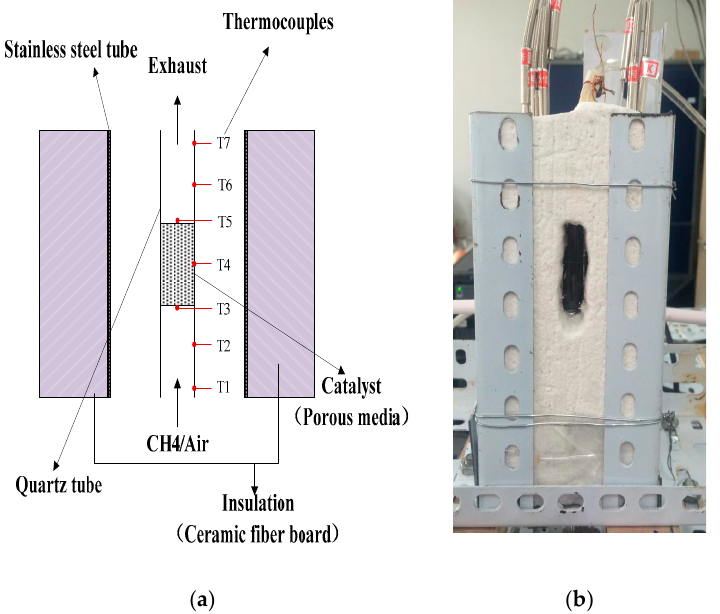
Figure 13. The combustor: ( a ) The schematic diagram of the catalytic combustor; ( b ) photograph of the combustor in the setup.